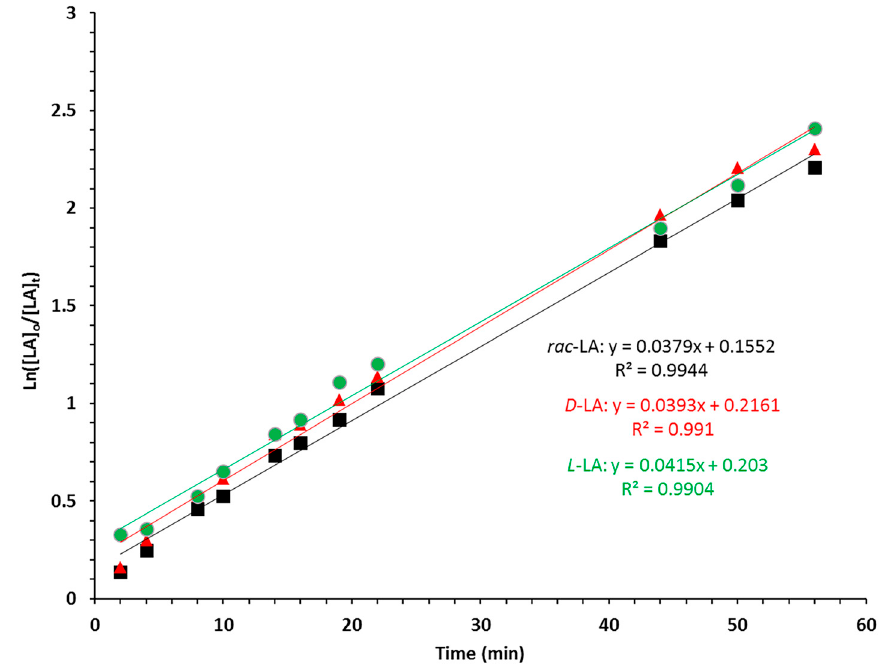
Figure 5. Semilogarithmic plot of ln([LA] 0 /[LA] t ) vs. time for D-LA, L-LA, and rac -LA polymerization Table S2).